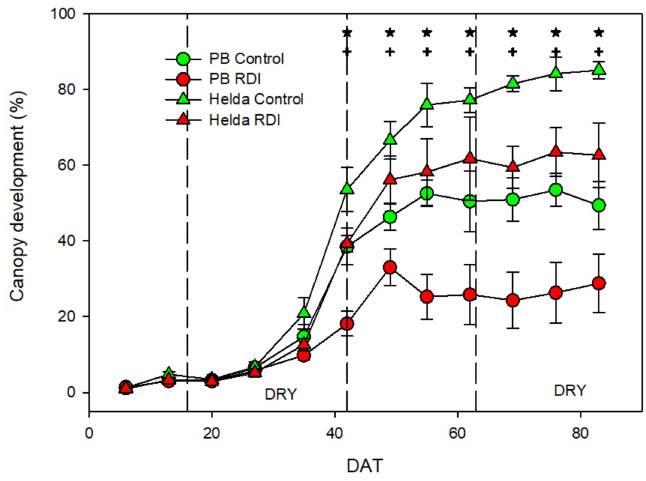
Figure 7. Pattern of canopy development in the 2021 season. Each point is the average of four measurements. Vertical lines represent the standard error. Triangles, cv Helda (upside down, Control; upright, RDI); Circles, cv Perfeccion Blanca (red, Control; orange, RDI). Asterisks (irrigation) and crosses (cultivar) indicate significant differences on that date ( p < 0.05). The word “dry” indicates a period without